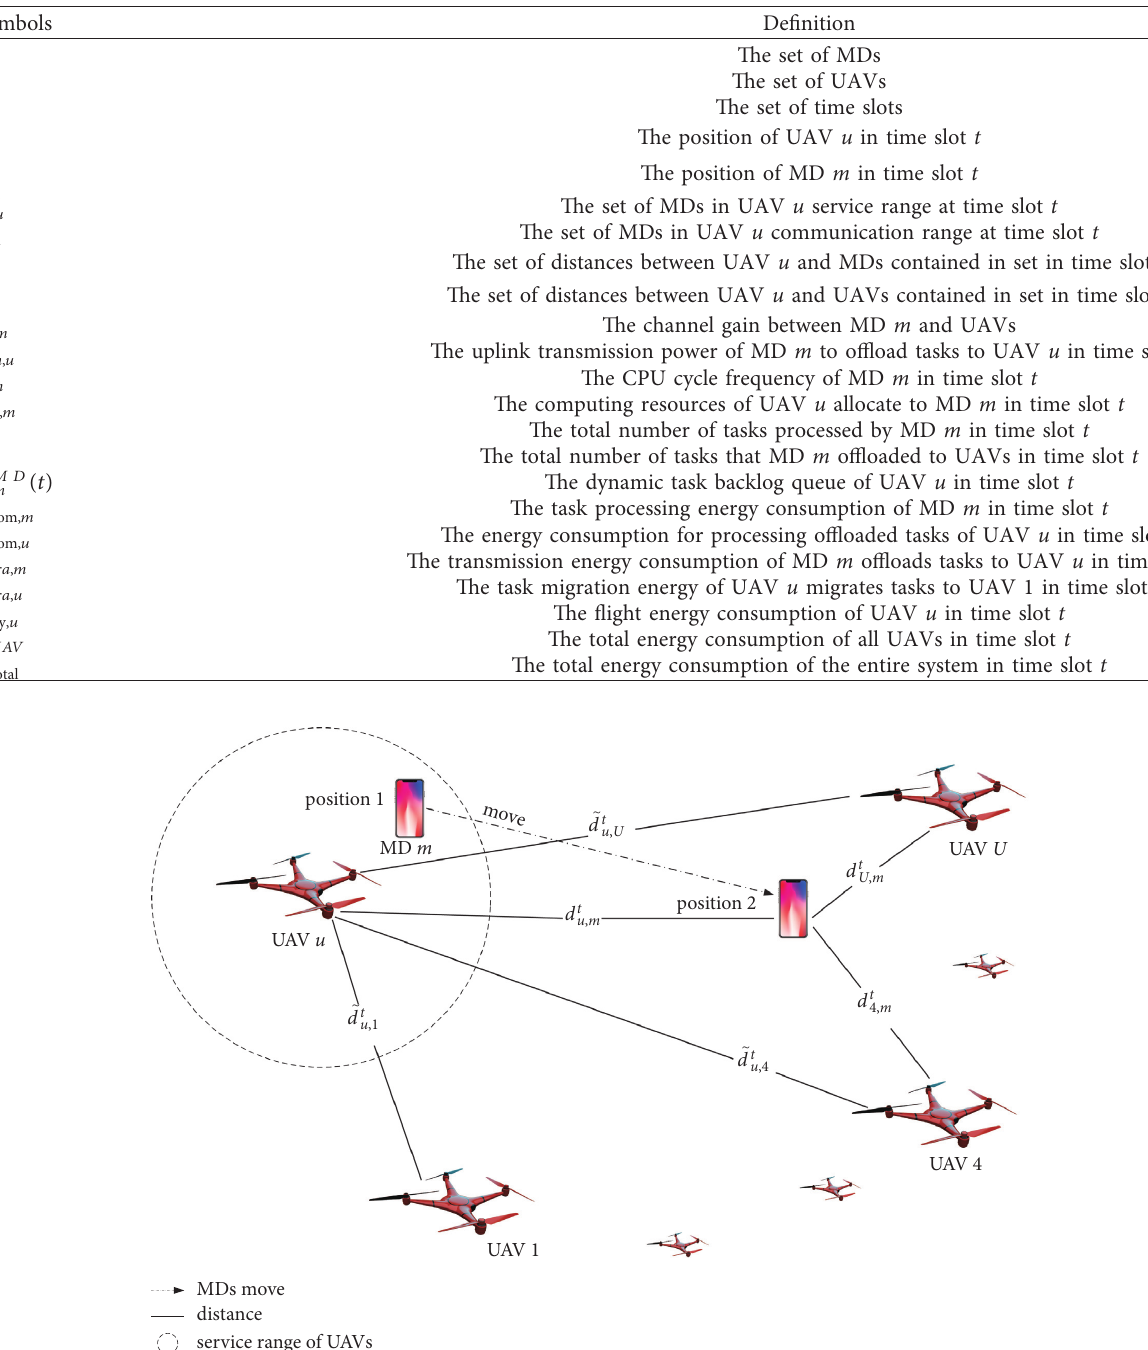
Table 1: Definition of main